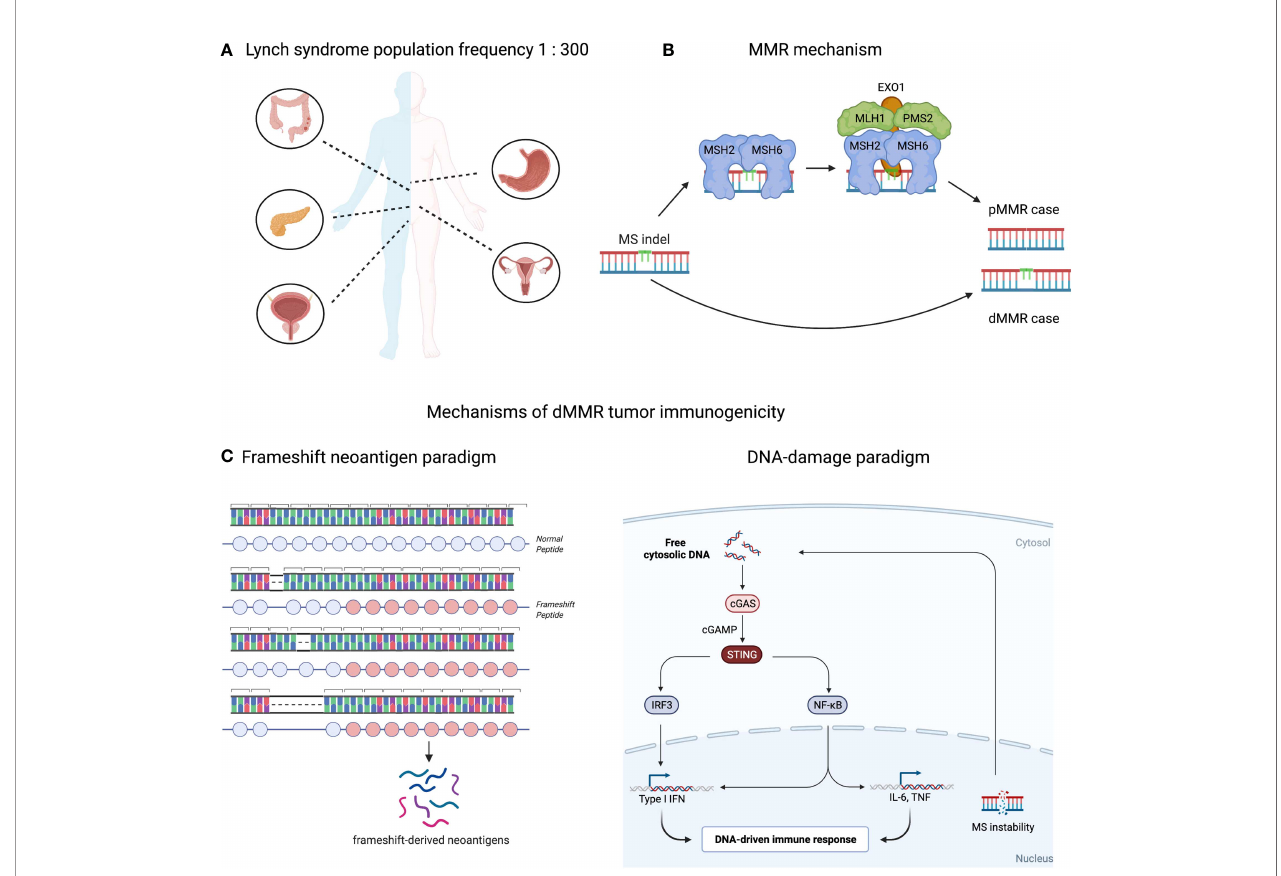
FIGURE 1 | Population, molecular and immunological aspects of mismatch-repair de fi cient (dMMR) tumors. (A) Predispositions to different cancers conferred by Lynch syndrome condition. Approximately 1 in 300 people in the U.S. has the Lynch Syndrome associated alleles. Carriers have 80% lifetime risk developing cancer including: colorectal, stomach, pancreas, urinary track and prostate for males and urinary, ovary or uterus tracks for females. In total, Lynch syndrome accounts for 2-3% solid tumor cases (11). (B) Mismatch repair (MMR) mechanism. MS indels occurring during DNA replication are repaired by MMR system (pro fi cient MMR). MSH2 - MSH3 or MSH2 - MSH6 complexes, called MutS a or MutS b , detect the error and recruit the MLH1 - PMS1 , MLH1 - PMS2 or MLH1 - MLH3 (MutL a / b / g complexes respectively) to bind to the DNA and bring DNA exonuclease with PCNA to the mutation site. The mismatch is then excised and repaired following by DNA resynthesis and re-ligation. These aberrations are left unrepaired in case of MMR de fi ciency. (C) Two complementary paradigms explaining immune responses in dMMR tumors: neoantigen-driven (left part), and innate immune driven (right